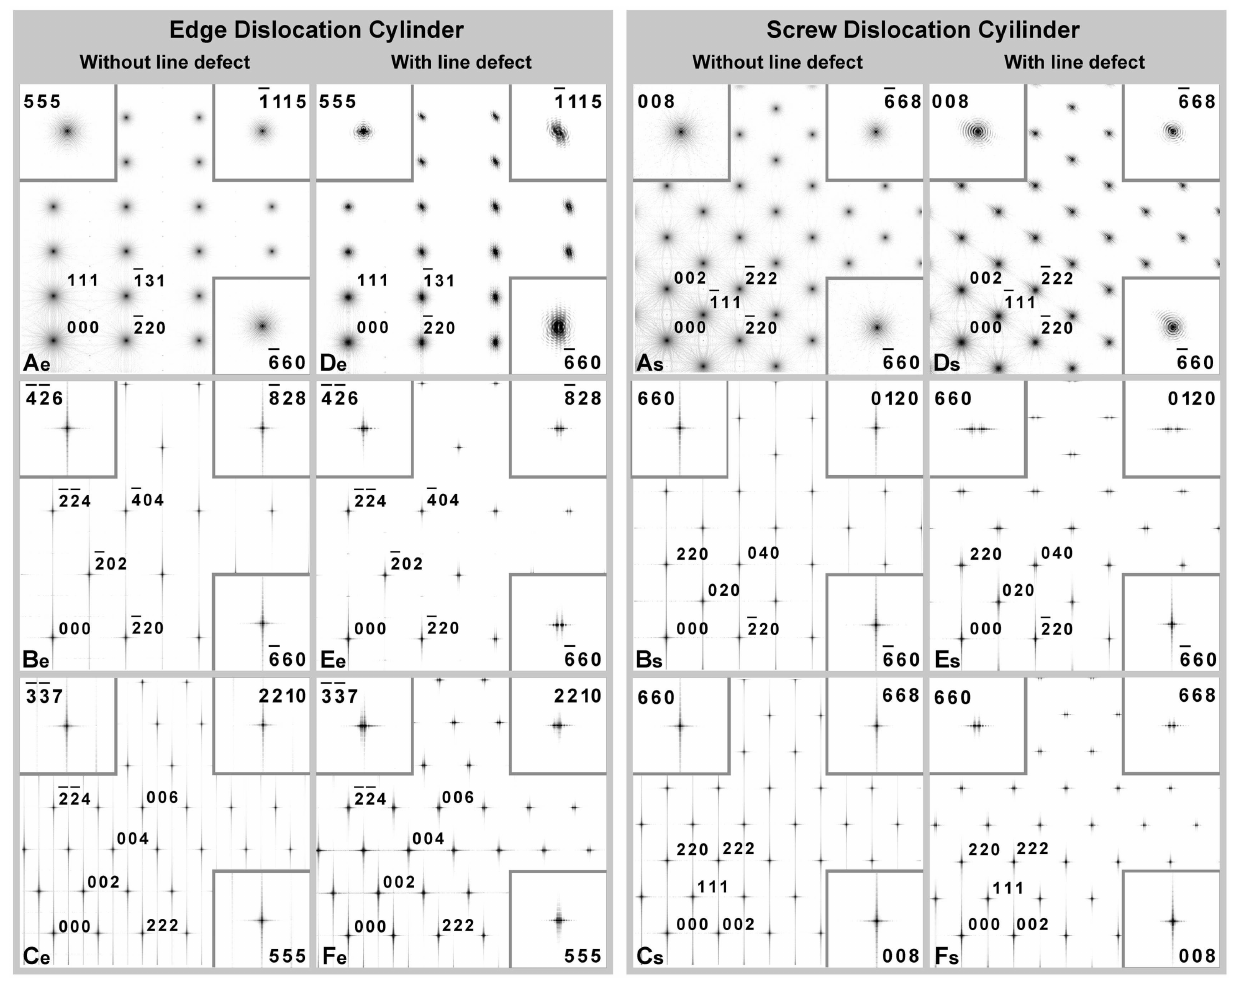
FIGURE 3 | X-ray diffraction intensity distribution in reciprocal space . Three different cross-sections are shown for cylindrical Pd nanocrystals ( D = H = 16nm) with edge dislocation (D e , E e , and F e ) and screw dislocation